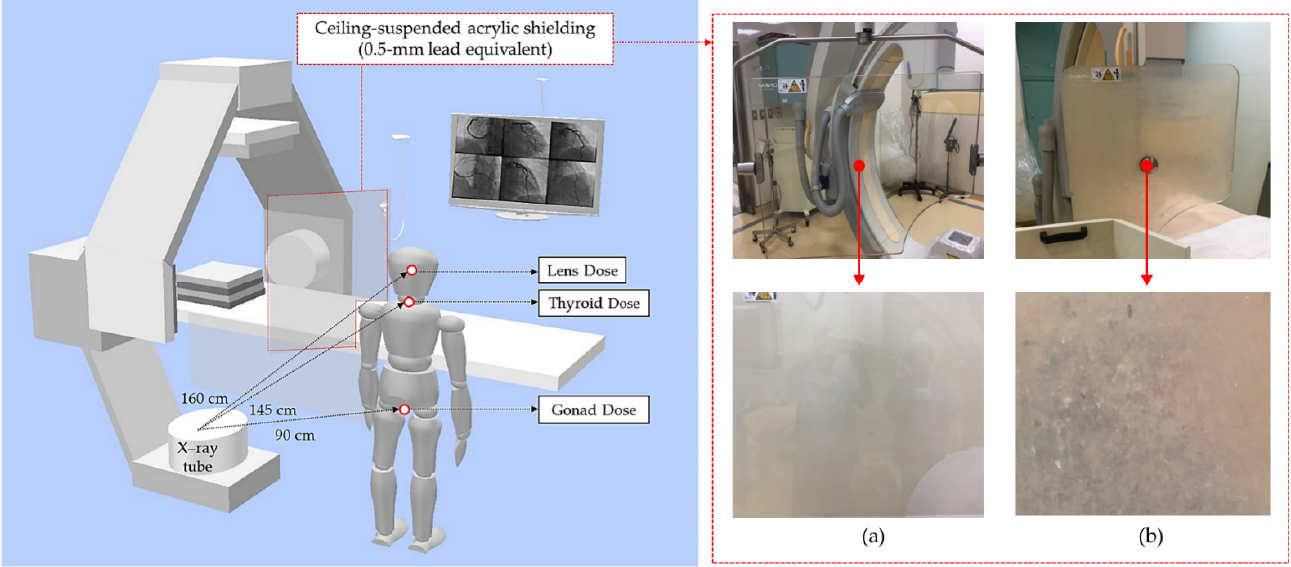
Figure 1. The geometry of measurement of the coronary angiography for cardiology: ( a ) clean lead glass shielding (CLS); ( b ) fogged lead glass shielding (FLS).